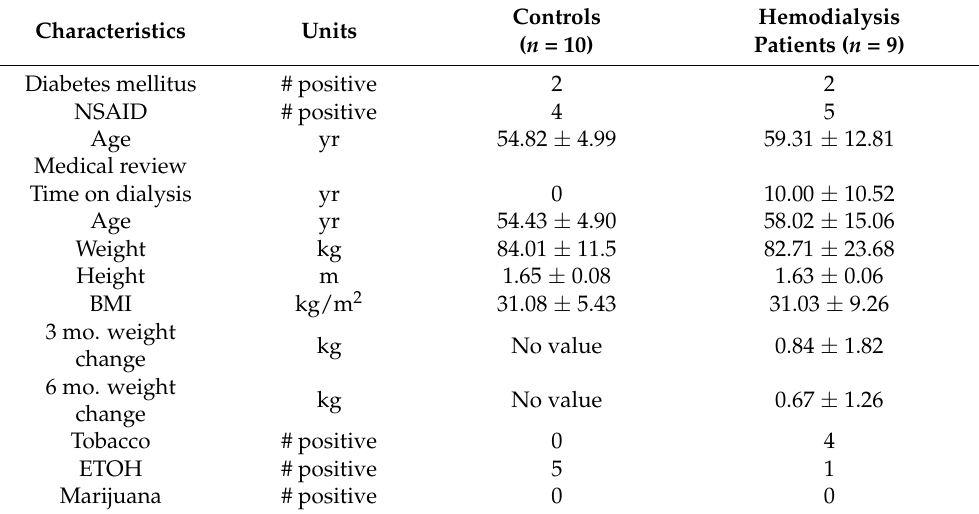
Table 3. Characteristics of female control subjects and female hemodialysis